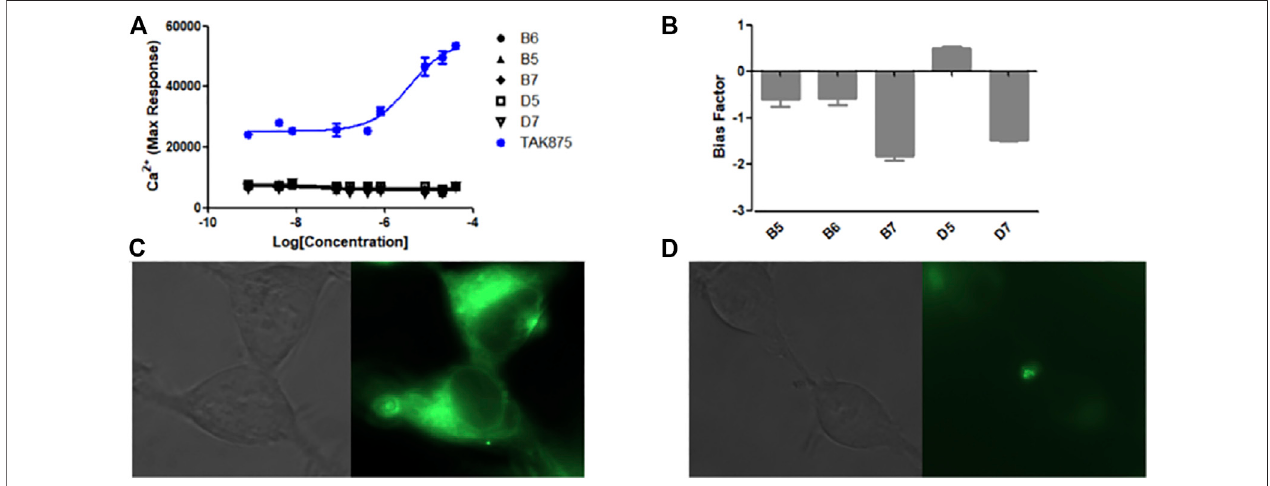
FIGURE 5 | (A) The Ca 2+ response of modi fi ed compounds (B5, B6, B7, D5, D7, TAK875) against GPR40. TAK875 is a positive GPR40 agonist reported in the literature; (B) The bias factor ofcompounds (B5, B6, B7,D5, D7); Exposure timewas500 ms; GFP channel; ×63lensmagni fi cation. (C) Imaging result ofN1 (0.5 μ M) in HEK293 cells (stably transfected with GPR120); (D) Imaging result of N1 (0.5 μ M) and D5 (10 μ M) in HEK293 cells (stably transfected with GPR120).